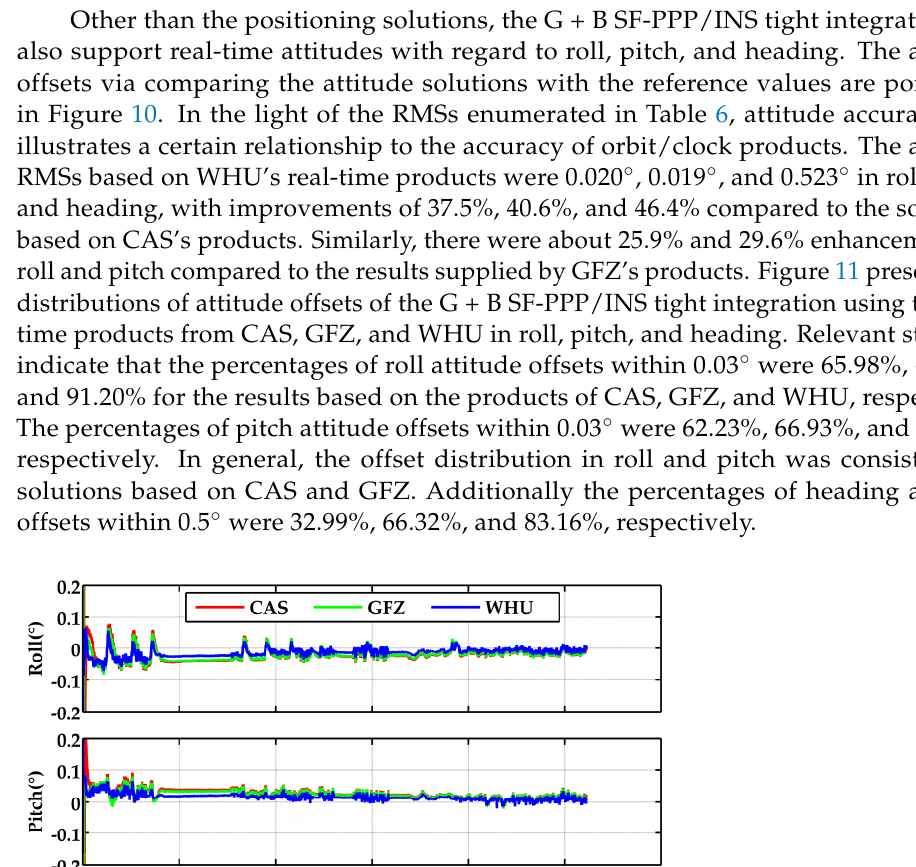
Figure 9. Distribution of position differences of G + B SF-PPP/INS tight integration in the horizontal direction ( left ) and vertical direction ( right ) using real-time products from CAS, GFZ, and WHU. Table 5. Position RMS and STD in the three directions of SF-PPP/INS tight integration using real- time products from CAS, GFZ, and WHU.